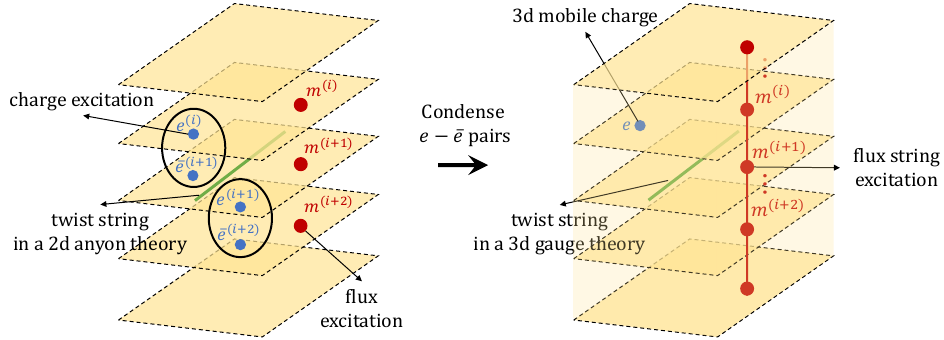
Figure 3: Layers of (2 + 1)D anyon theories are prepared, and then pairs of particle excitations in adjacent layers are